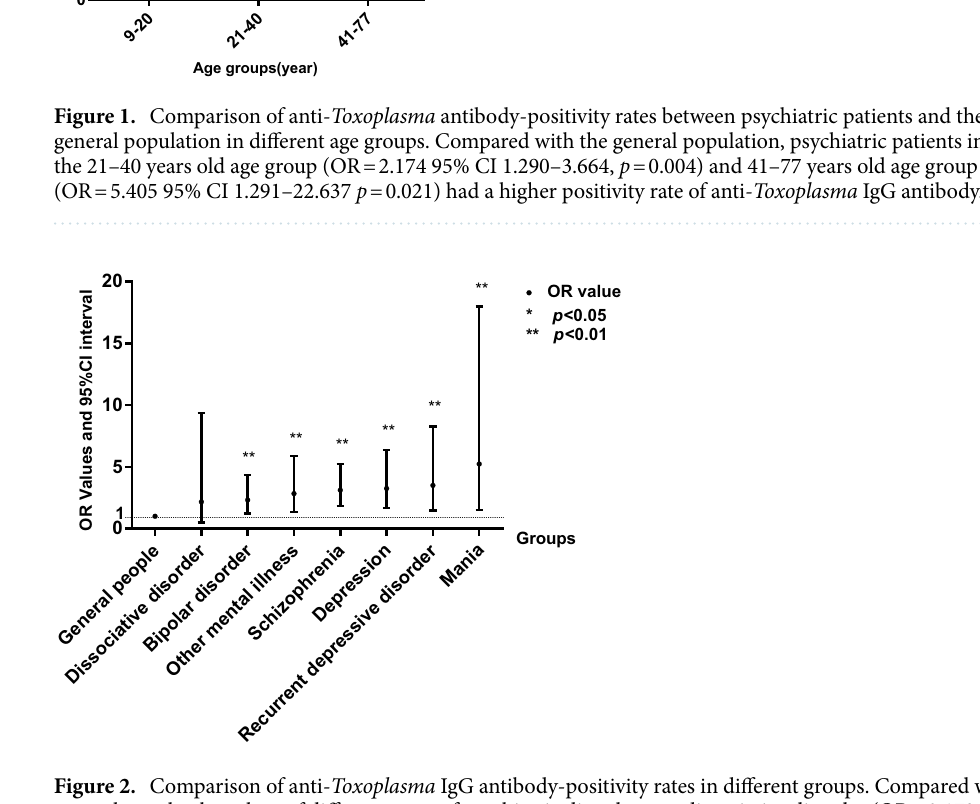
Figure 2. Comparison of anti- Toxoplasma IgG antibody-positivity rates in different groups. Compared with general people, the values of different types of psychiatric disorders are dissociative disorder (OR = 2.170 95% CI 0.504–9.350 p = 0.299), bipolar disorder (OR = 2.327 95% CI 1.249–4.337 p = 0.008), schizophrenia (OR = 3.136 95% CI 1.864–5.275 p = 0.000), depression (OR = 3.466 95% CI 1.740–6.906 p = 0.000), recurrent depressive disorder (OR = 3.160 95% CI 1.398–7.142 p = 0.006), mania (OR = 5.149 95% CI 1.501–17.659 p = 0.009), and others (OR = 2.821 95% CI 1.364–5.837 p =